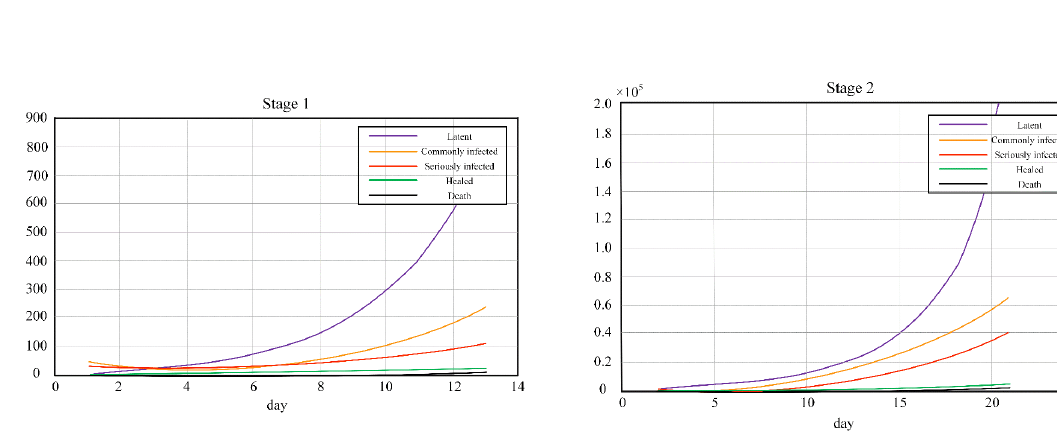
Figure 5. Number of different people in each stage.